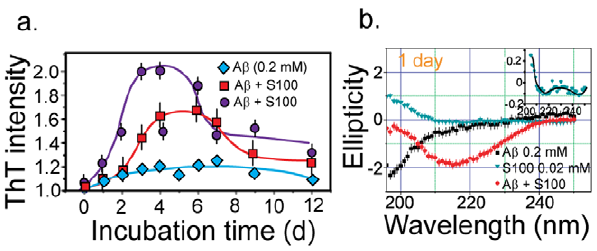
Figure 2. ThT and CD spectra of S100A9/A b 1–40 (0.2 mM) complex. (a) Kinetics of S100A9/A b 1–40 mixture amyloid formation at pH 7.4 and 37 0 C monitored by the thioflavin-T assay. Rhombuses correspond to 0.2 mM A b 1–40. Squares correspond to 0.2 mM S100A9 and 0.1 mM A b 1–40. Circles correspond to 0.02 mM S100A9 and 0.2 mM A b 1–40 (b) CD spectra of A b 1–40 peptide (0.2 mM), S100A9 (0.02 mM) and their mixture, incubated at pH 7.4 and 37 0 C for 1